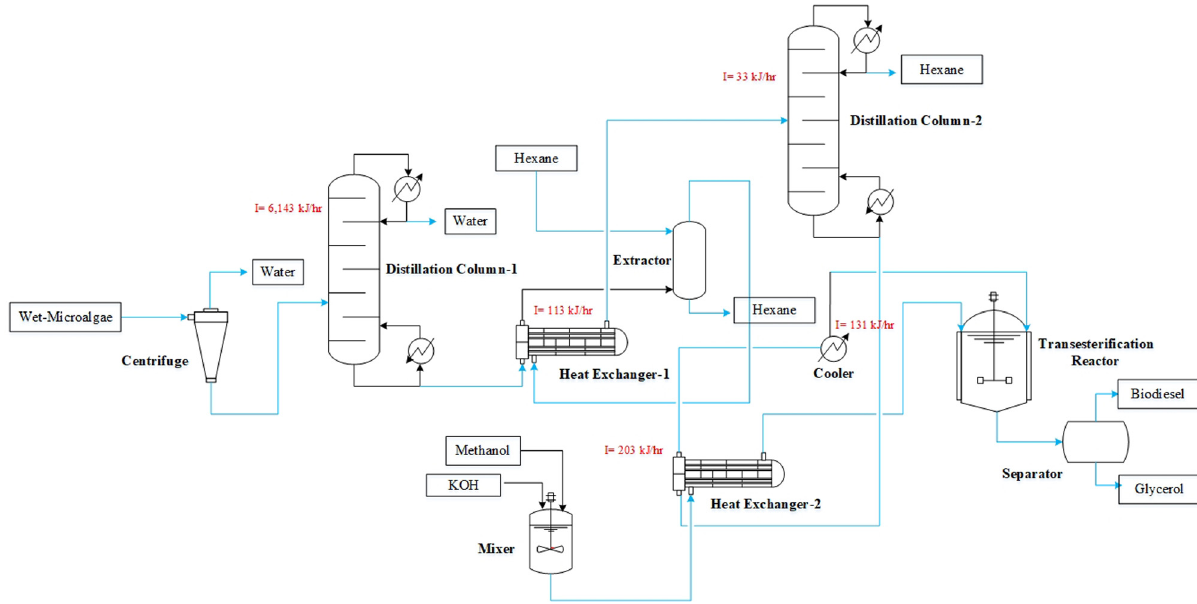
Figure 3: Biodiesel production process fl ow diagram of conventional